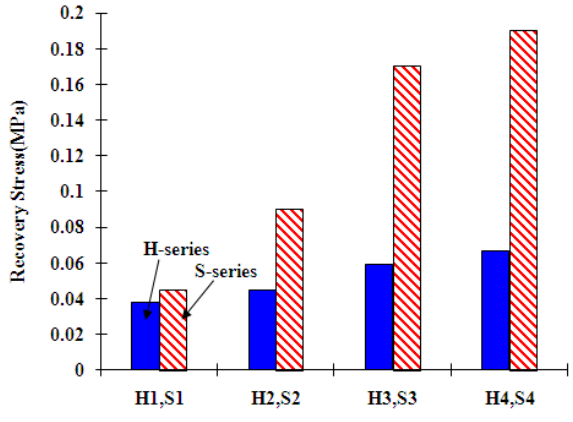
Figure 8. Summary of recovery stress of different SMPUs at 60 °C and 50% strain.